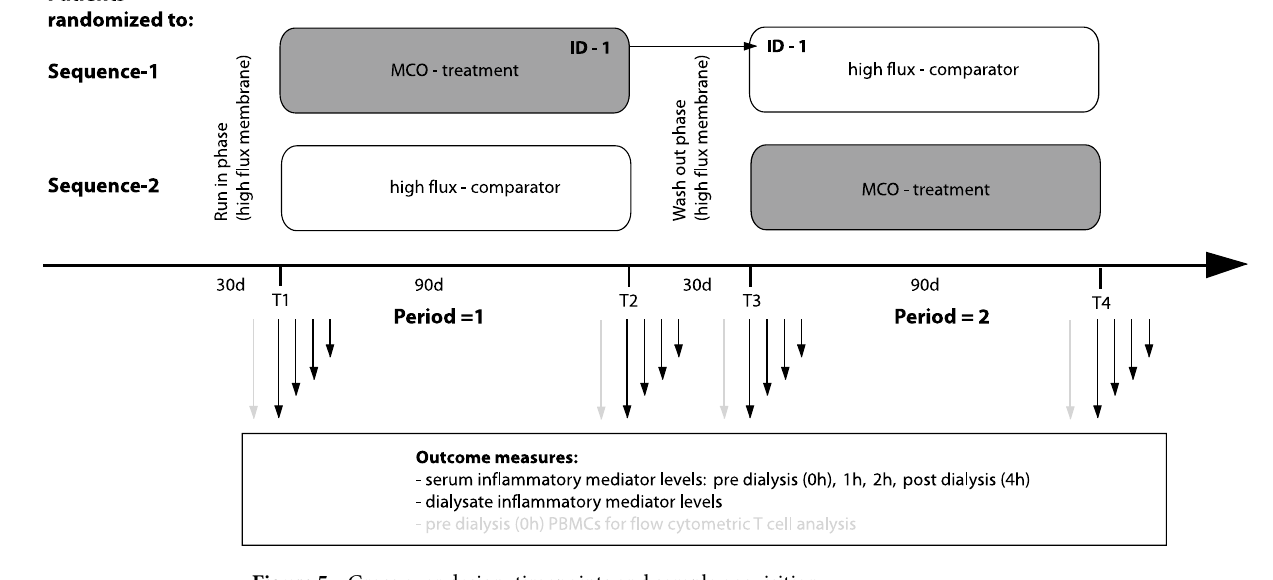
Figure 5. Cross over design, timepoints and sample